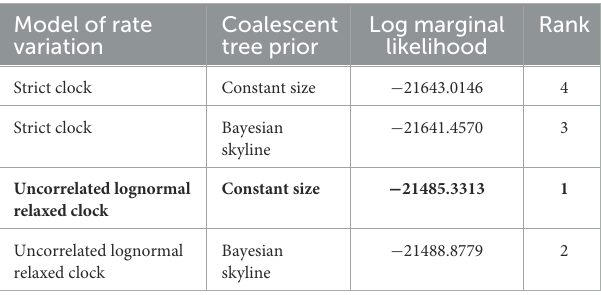
TABLE 1 The marginal likelihoods estimated of molecular clock models and coalescent